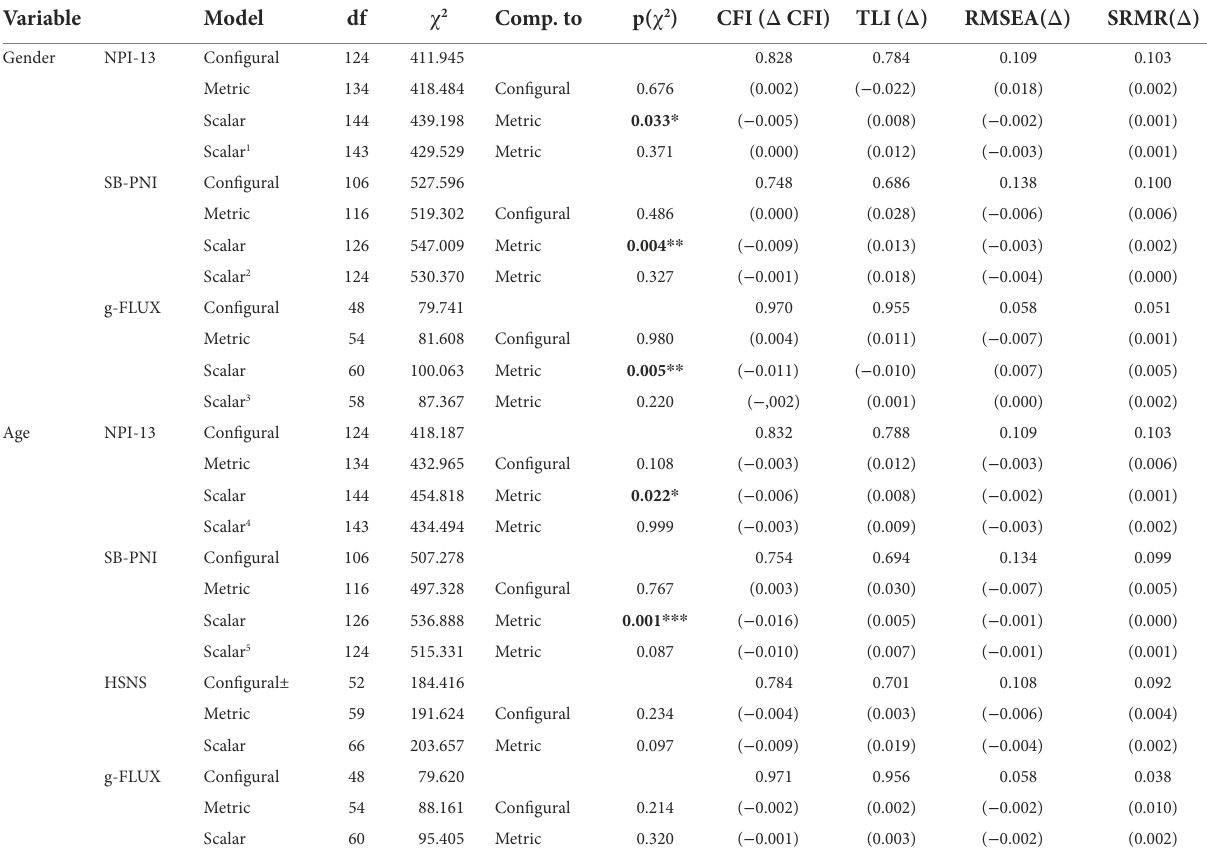
TABLE 3 Invariance test fit indices between configural, metric and scalar models for age and gender.